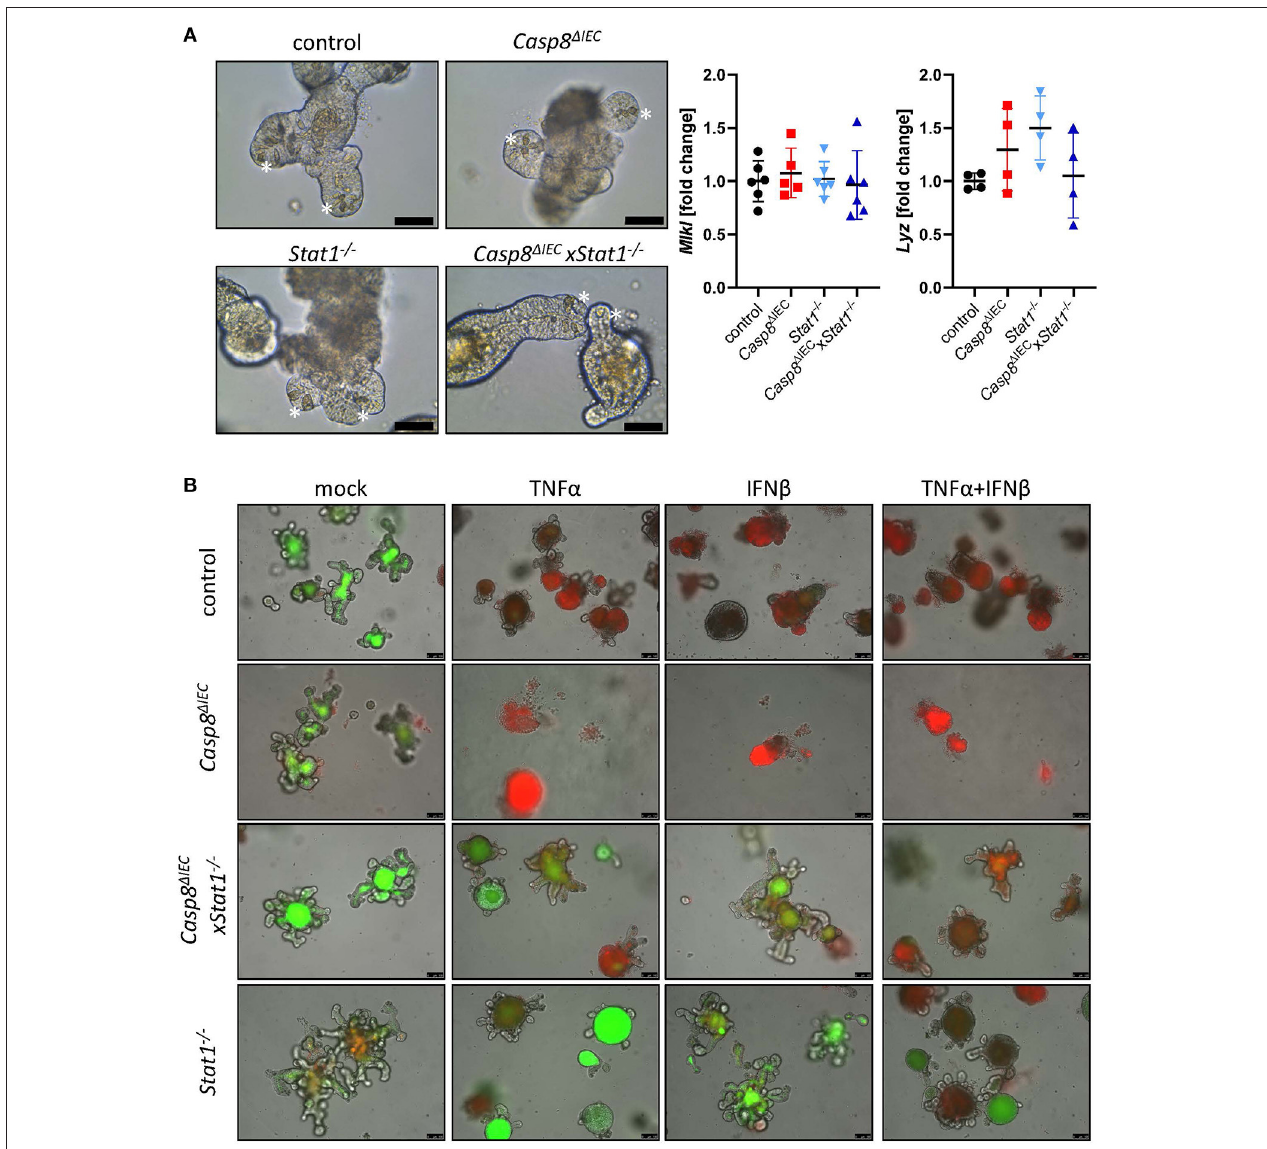
FIGURE 2 | STAT1 coordinates interferon induced cell death in vitro . (A) Representative pictures of organoids derived from of control, Casp8 1 IEC , Stat1 − / − and Casp8 1 IEC xStat1 − / − mice. (Scale bar: 50 µ m, Paneth cells marked with asterisks). Gene transcription analysis of organoid mRNA expression. Gapdh was used as housekeeping gene. Gene expression levels are shown as fold changes. Error bars indicate + /-SD. (B) Organoids derived from of control, Casp8 1 IEC , Stat1 − / − and Casp8 1 IEC xStat1 − / − mice. Stimulated with TNF α (25ng/ml) and IFN β (100ng/ml) were stained with propidium iodide (red, dead cells) and live cells visualized by autofluorescence (green; scale bar: 100 µ